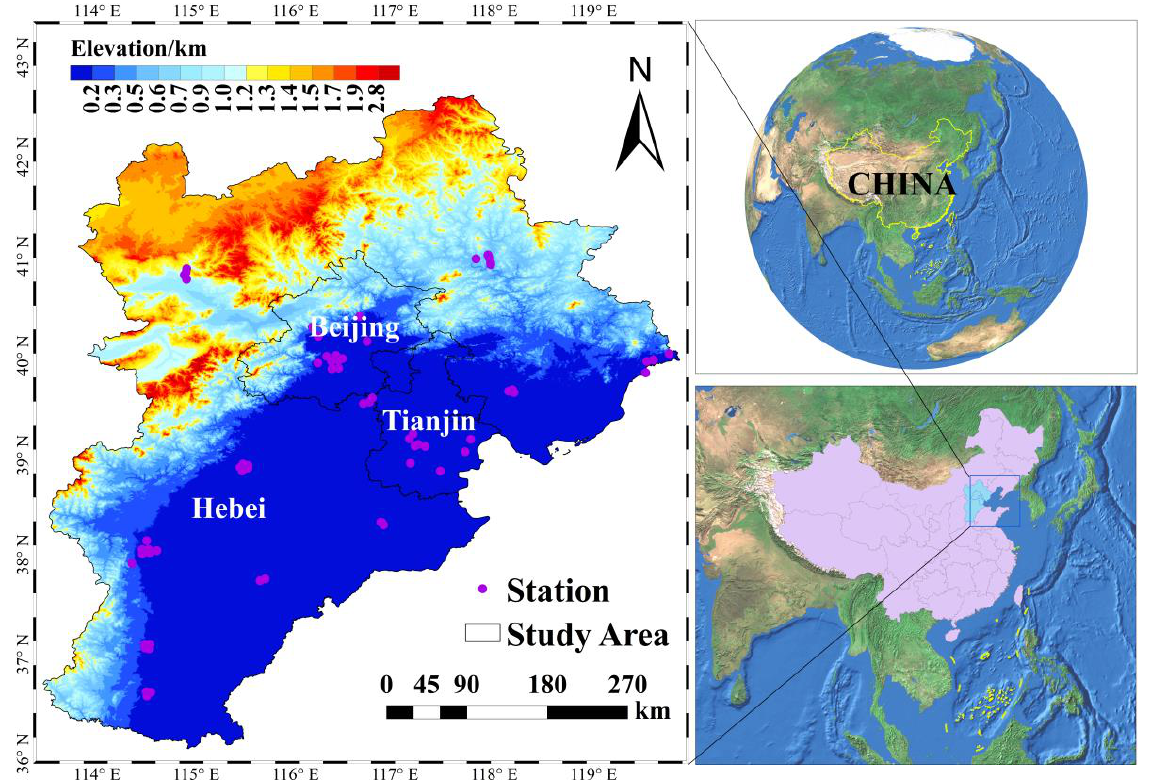
Figure 1. Location of the BTH and distribution of air quality monitoring stations. The map is based on the standard map number GS (2019) 1822 downloaded from the standard map service website of the National Bureau of Mapping Geographic Information, and the base map is not modified.